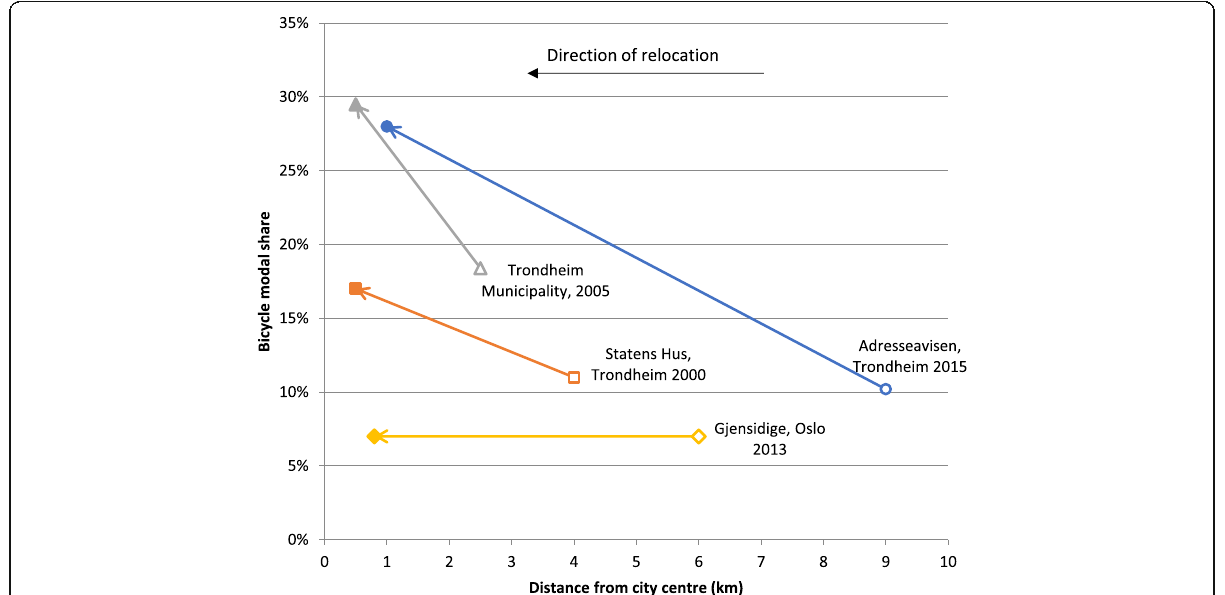
Fig. 6 Bicycle modal share for commuting journeys before and after relocation from suburbs to the inner